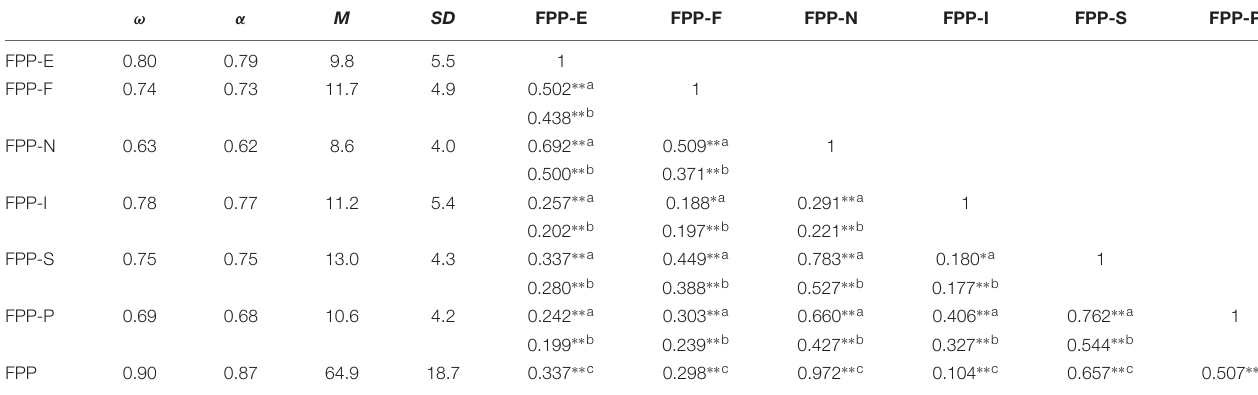
TABLE 3 | Characteristics of scales and factors, respectively ( N = 305).